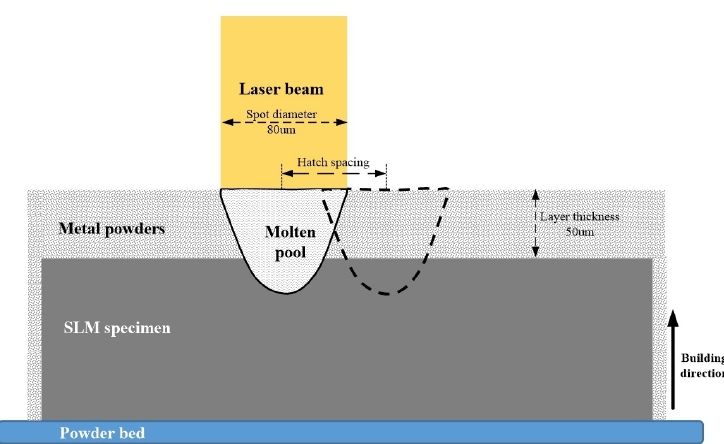
Figure 3. Schematic illustration of the SLM processing parameters.